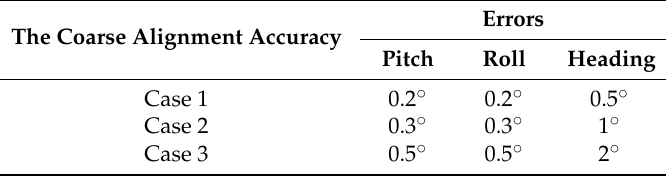
Table 2. The different initial conditions for the closed-loop simulations.